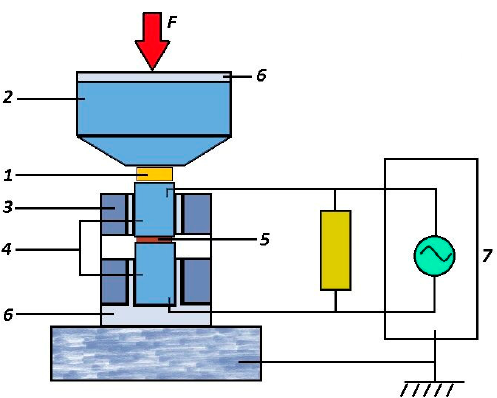
Figure 3. Diagram of an improved high-pressure cell (From [48] with permission).